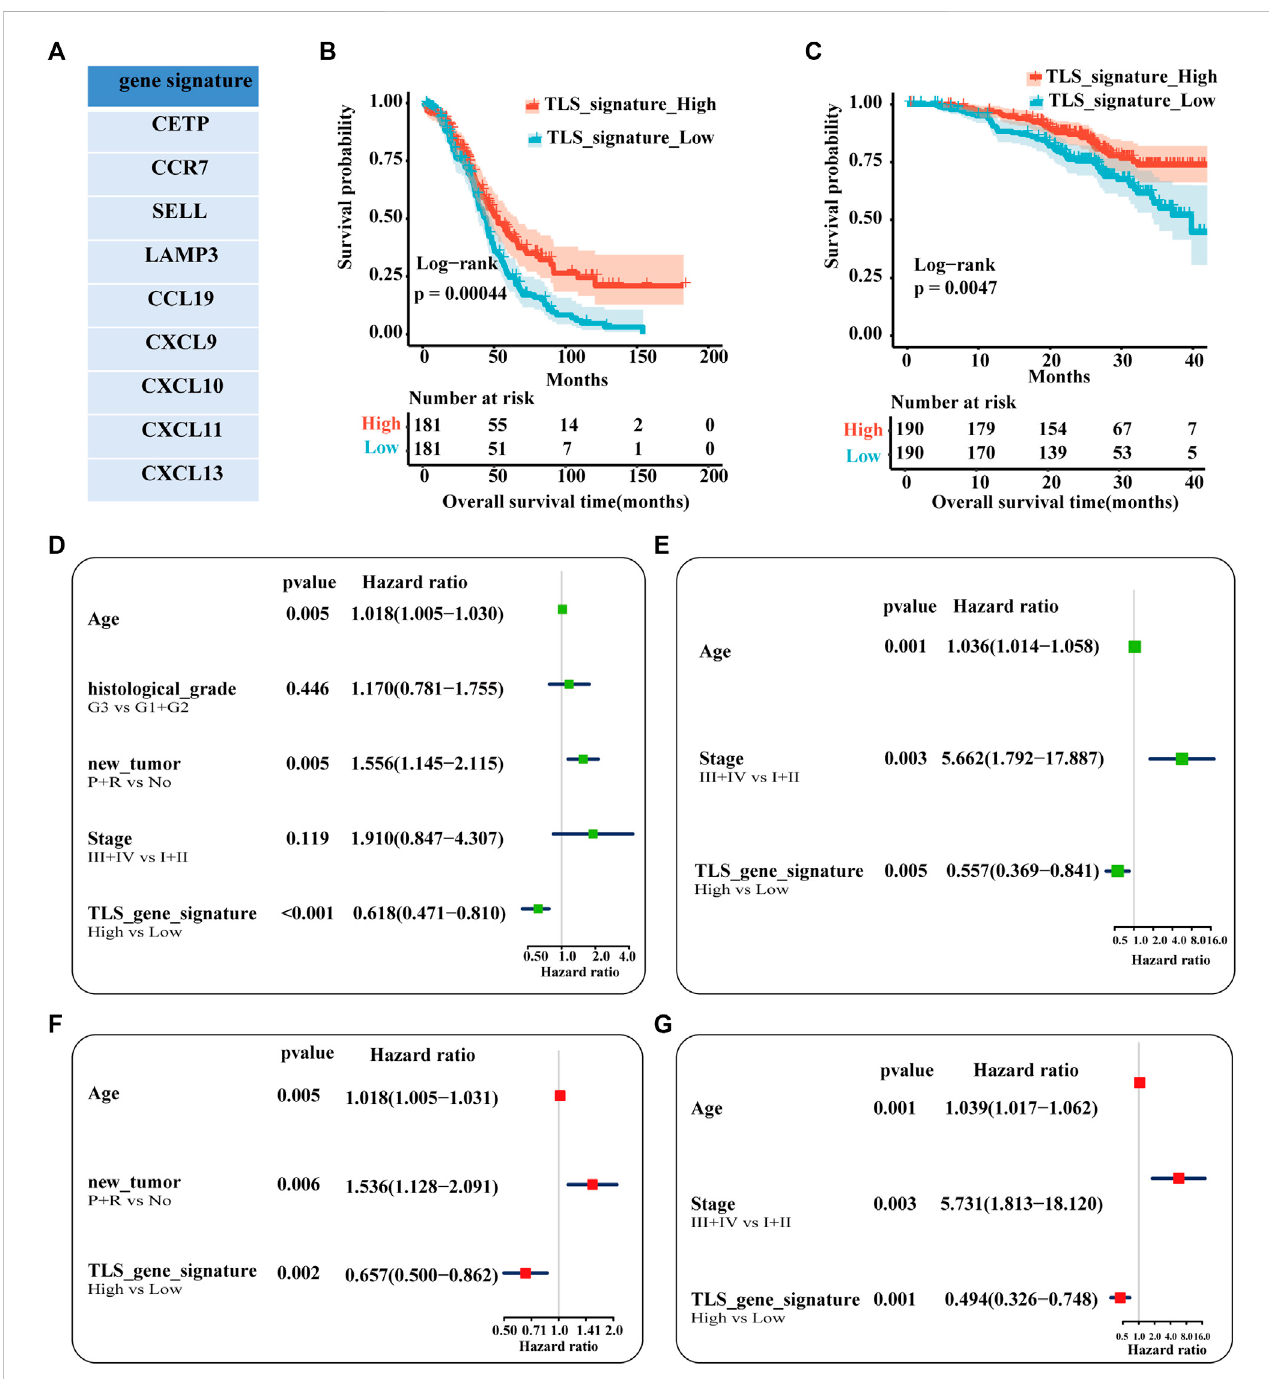
FIGURE 3 Analysis of the independence of TLS gene signature on prognosis. (A) The nine genes associated with better prognosis in TCGA-OV dataset. Survival analysis of OV patients between the high and low TLS signature subgroups (B,C) : (B) The TCGA cohort as training set. (B) The GSE queue as validation set. Univariable analysis (D) and multivariable analysis (F) of the overall survival in TCGA-OV cohort. Univariable analysis (E) and multivariable analysis (G) of the overall survival in GSE140082 cohort. (tumor status: No = without-tumor; P = progression; R = recurrence, p <